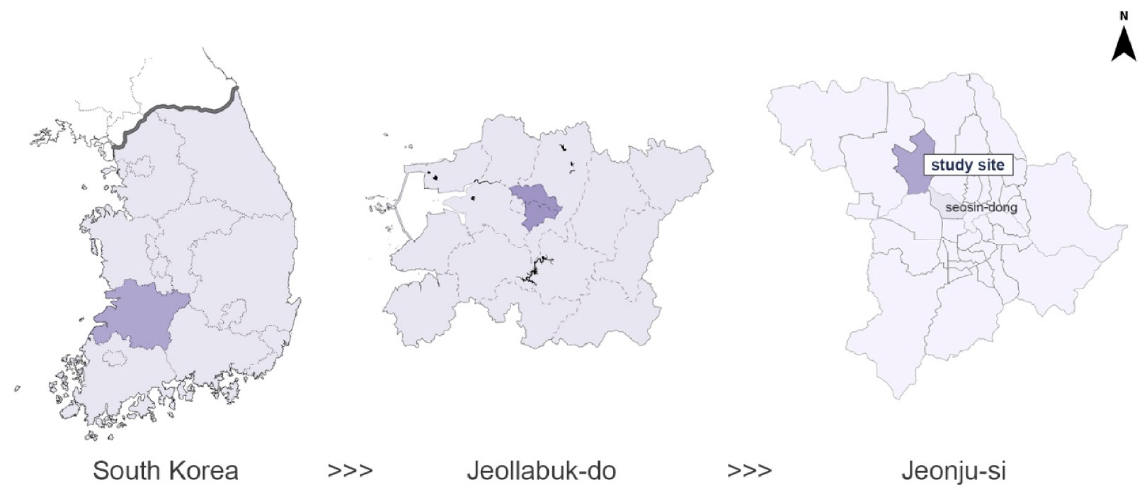
Figure 1. Map of the study area of Jeonju-si in Jeollabuk-do, South Korea.